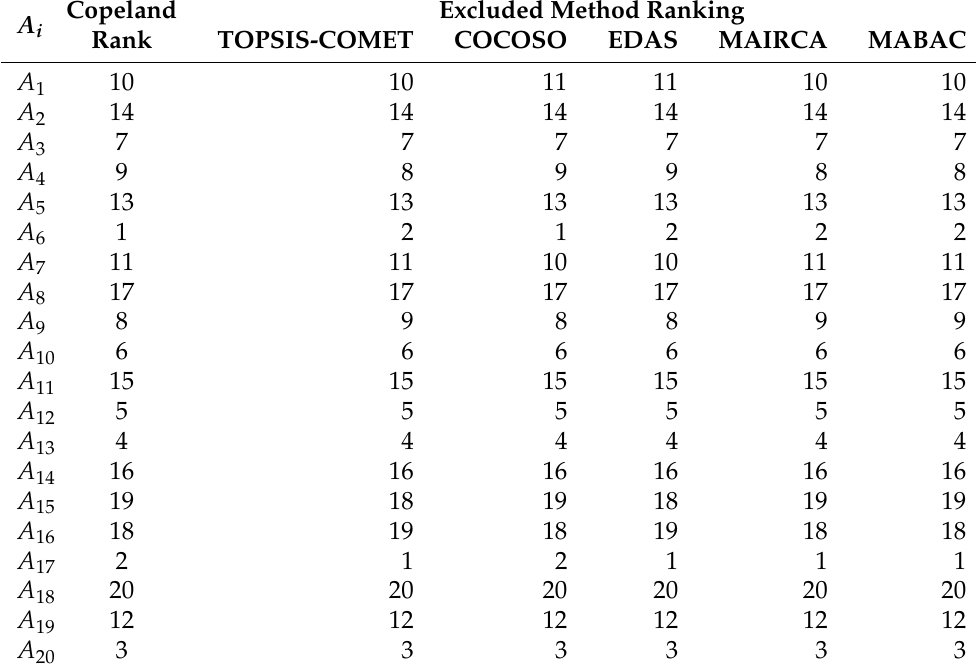
Table 7. Rank values for compromise ranking candidates with consideration of the little set.